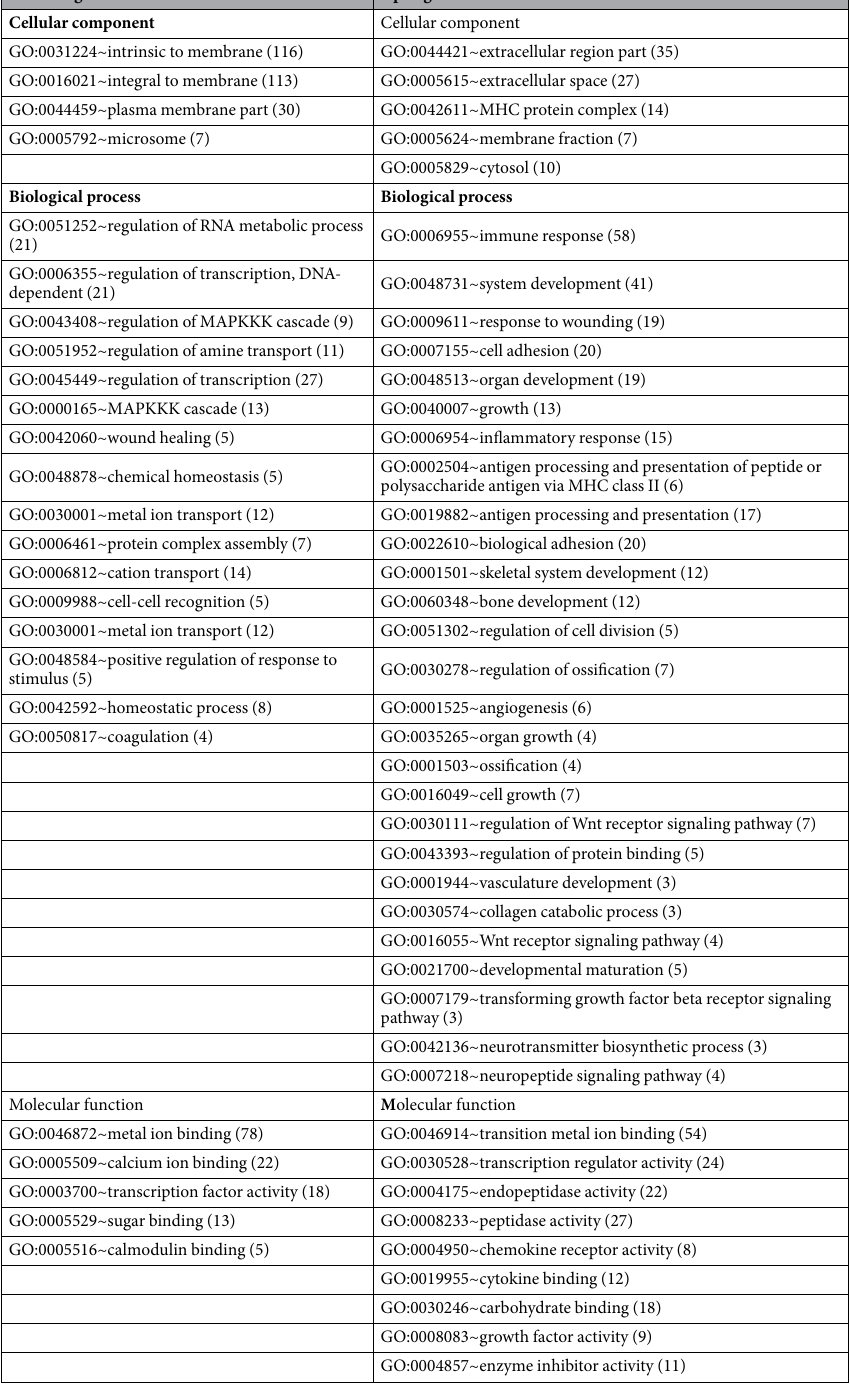
Table 3. Over-represented gene ontology (GO) terms (P < 0.05) in comparison between periosteum of defects site and control site at week 2, with number of genes indicated in